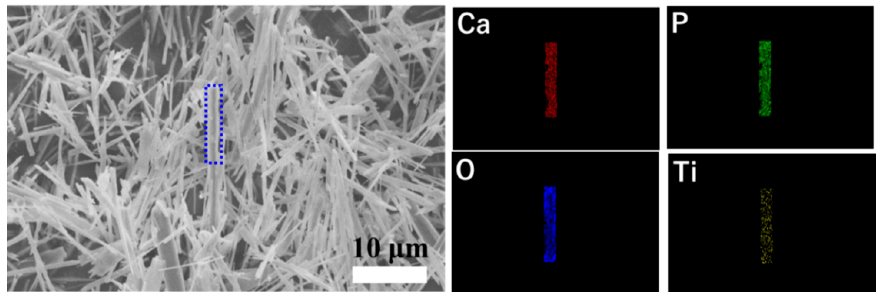
Figure 3. FT-IR spectra of ( a ) the TiO 2 -coated HAp and ( b ) hydrothermally-synthesized HAp.